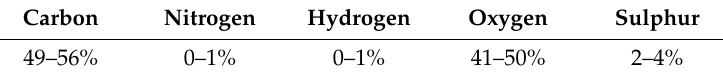
Table 4. Elemental analysis of graphene oxide [58].